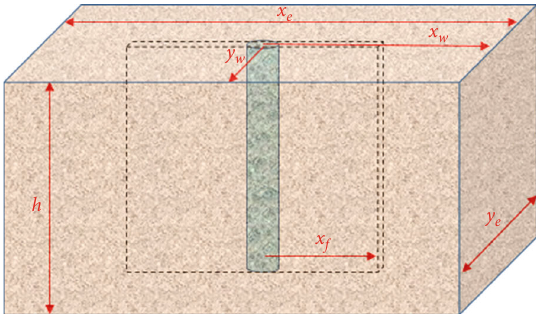
Figure 5: Parameters between grids i and j